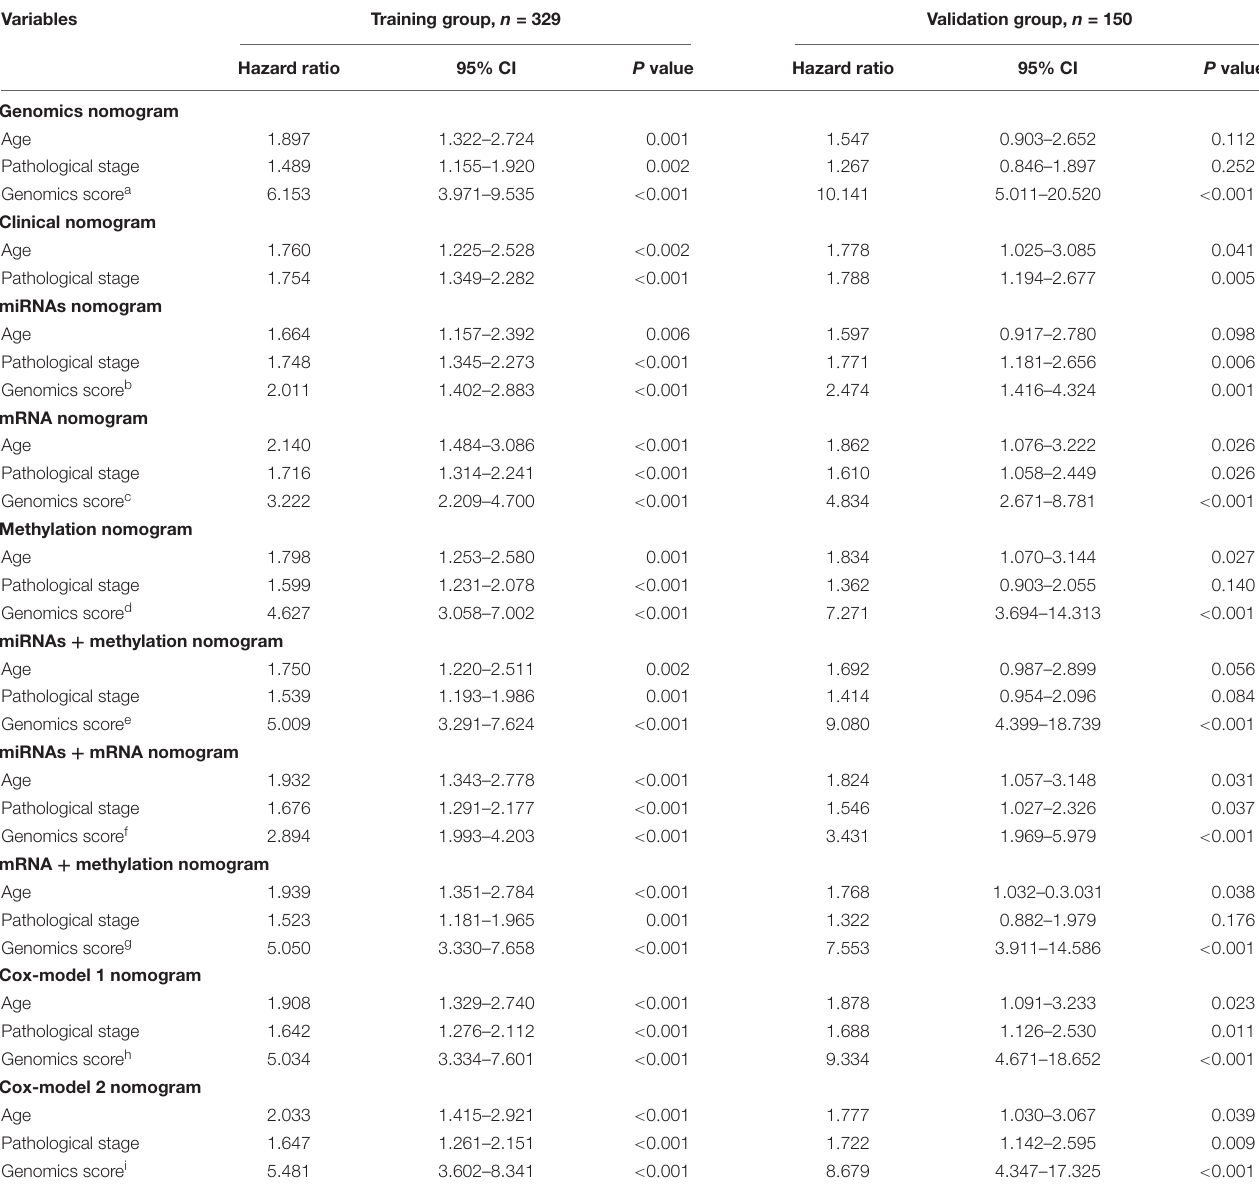
TABLE 3 | Comparison of different genomics score models (based on the median value) for overall survival in the training group and the validation